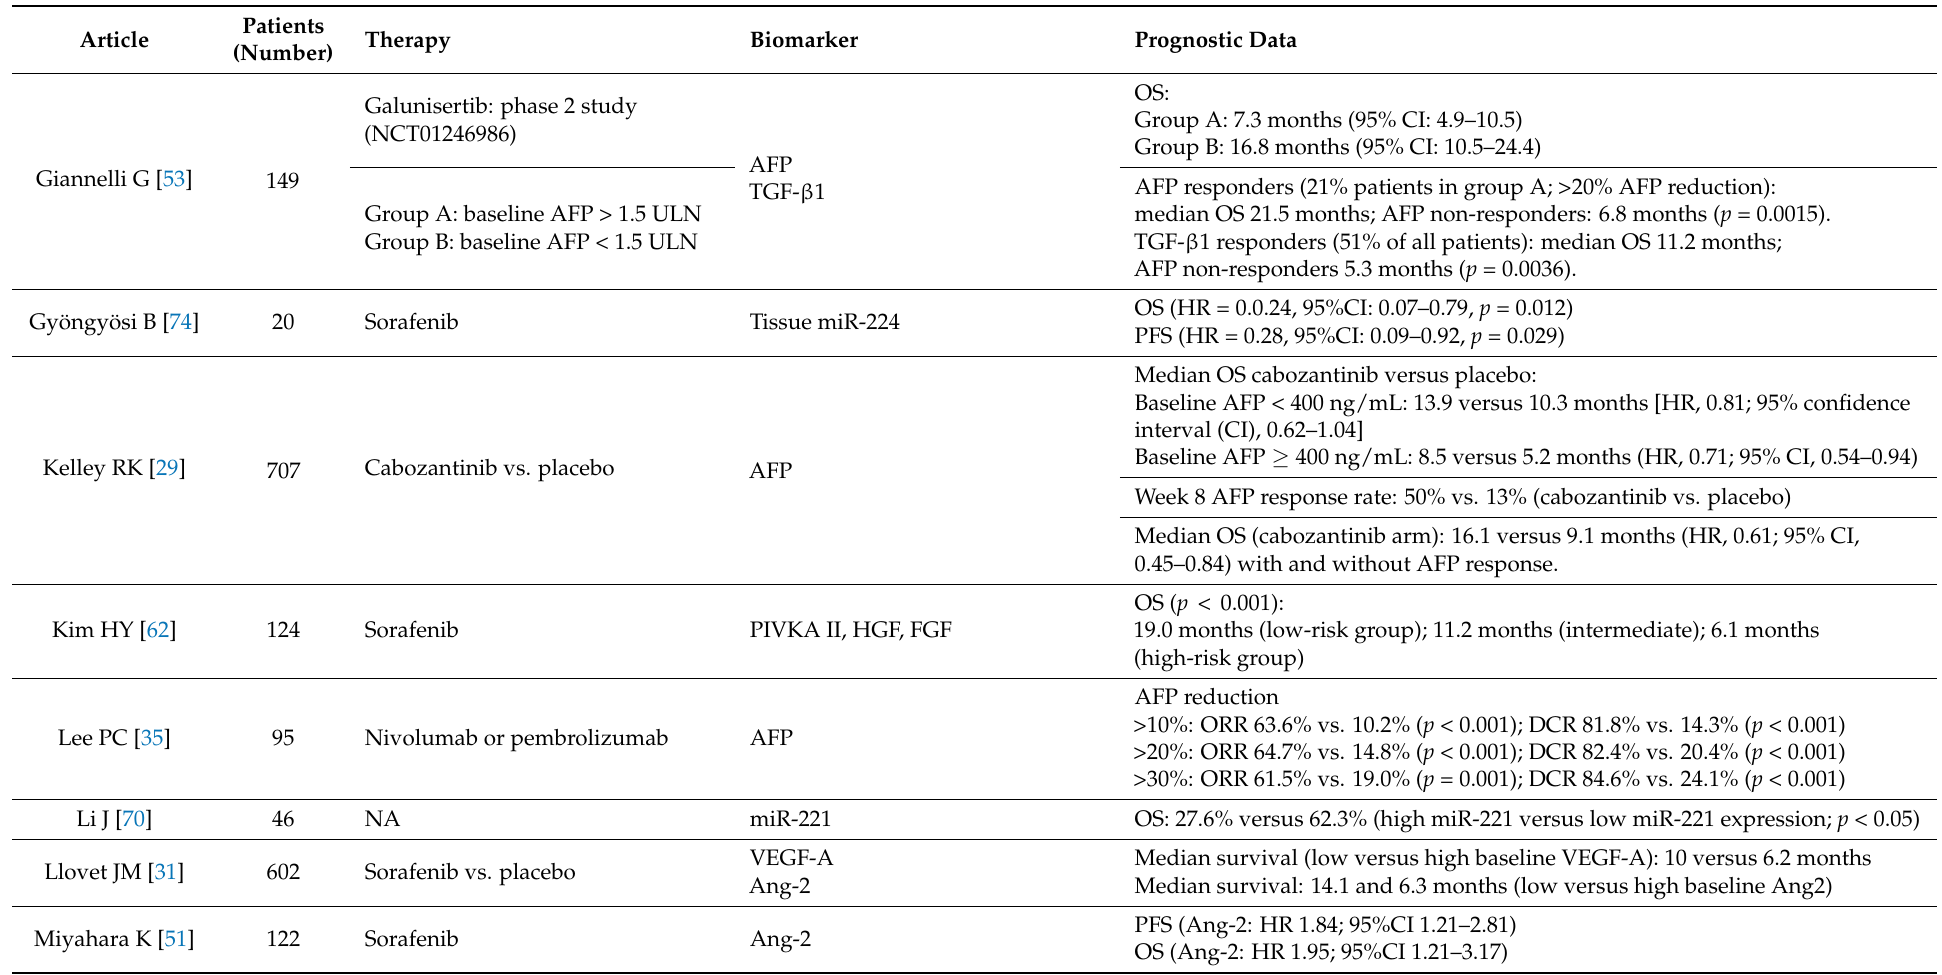
Table 1. The prognostic role of clinical biomarkers in patients with advanced hepatocellular